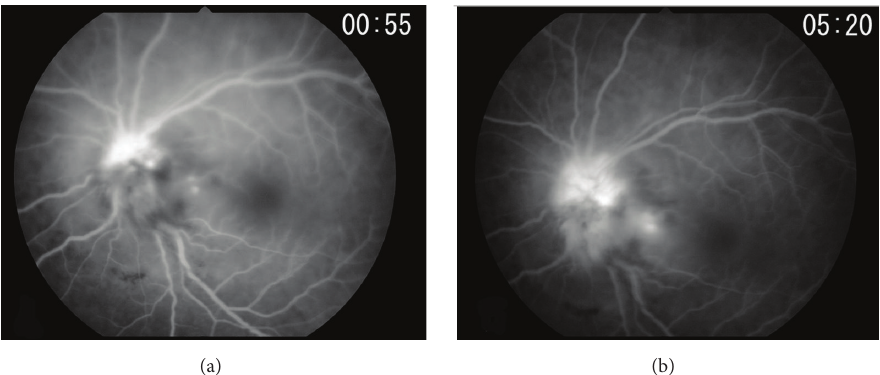
Figure 2: Fluorescein angiograms (FA) at the early phase (a) and late phase (b). FA images show subretinal fluid during the early phase (a) that is still present in the late stage (b).